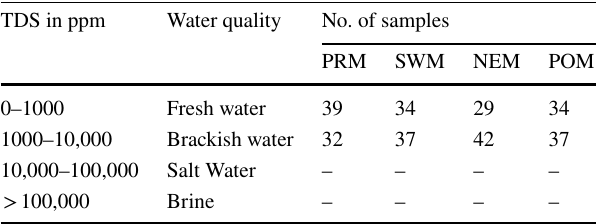
Table 4 Water quality classification based on TDS Content by Carroll